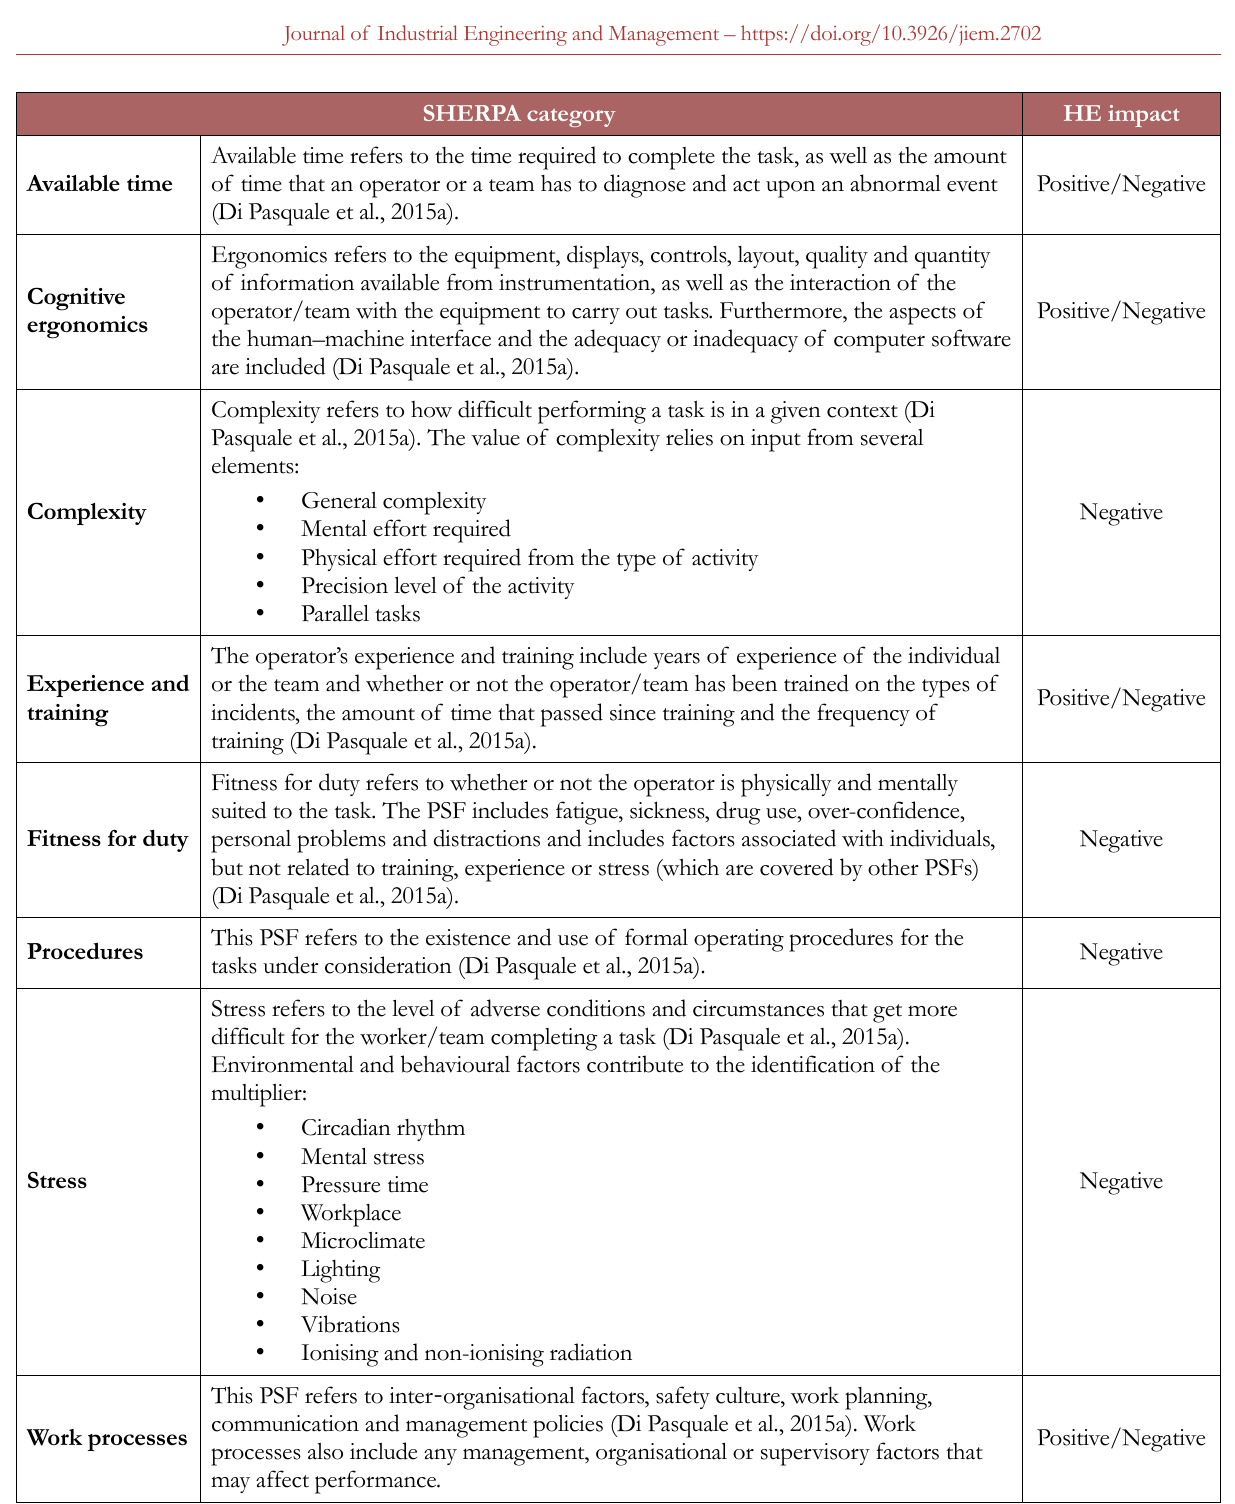
Table 1. Performance shaping factors of the SHERPA method (Di Pasquale et al., 2015a)